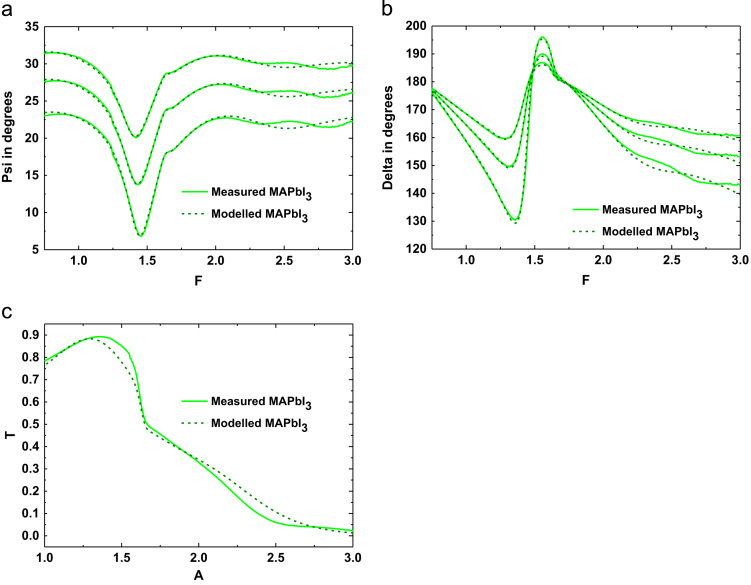
Modelled (dash lines) and experimental (solid lines) (a) amplitude component Ψ; (b) phase difference Δ and (c) Transmission T of CH3NH3PbI3 perovskite film on TiO2 coated borosilicate glass substrate.